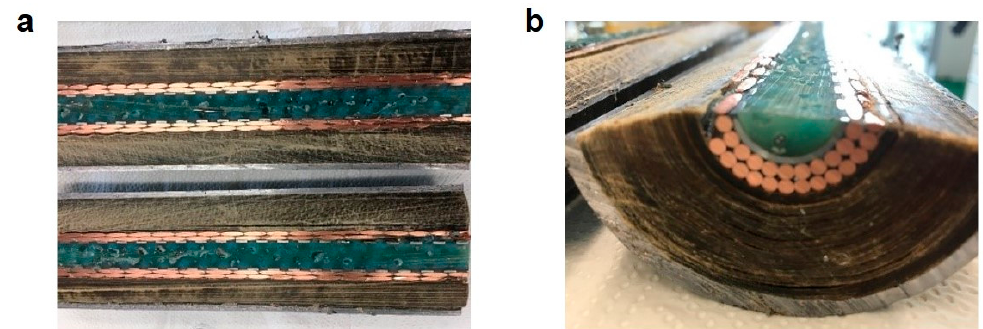
Figure 4. ( a ) Axial section and ( b ) cross-section of the cable after clogging by in situ polymerization and complete oil removal by water displacement.